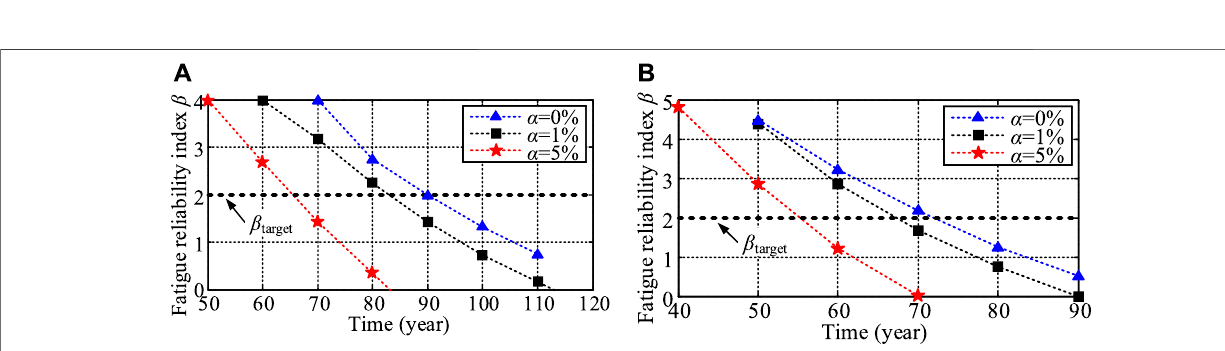
Frontiers in Materials |